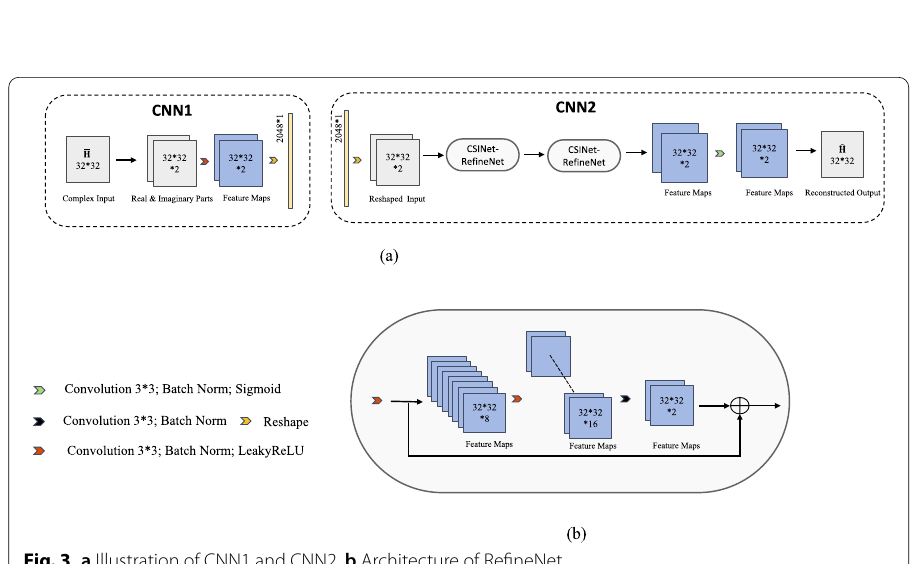
Fig. 2 a Offline codebook design. b Online codeword selection